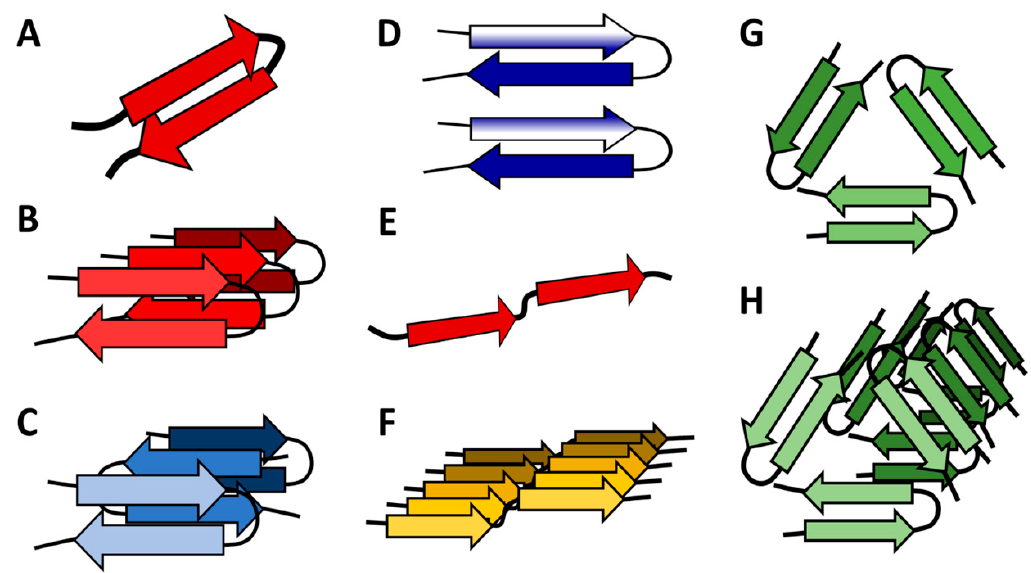
Figure 2. β -Sheet-containing forms of amyloid β . In dependence on the environment and peptide concentration, A β may organize into distinct combinations of β -rich tertiary and quaternary structures. ( A ) β -hairpin; ( B ) parallel β -hairpin structure. Particular peptides are interconnected through non-covalent interactions; ( C ) antiparallel arrangement, characteristic for toxic oligomers of amyloid peptide; ( D ) different mutual positions of internal β -sheets result from rotation of the upper part of the amyloid peptide; ( E ) an extended conformation of β -sheets containing amyloid monomer; ( F ) structure of amyloid fibril with parallel orientation of A β monomers. ( G ) Supposed organization of a trimer; ( H ) organization of a fiber formed of trimers. Many other possibilities of fibrillar and globular aggregates including pentamers and hexamers were described, but are not shown here. Adjusted according to [39,41,61,74].